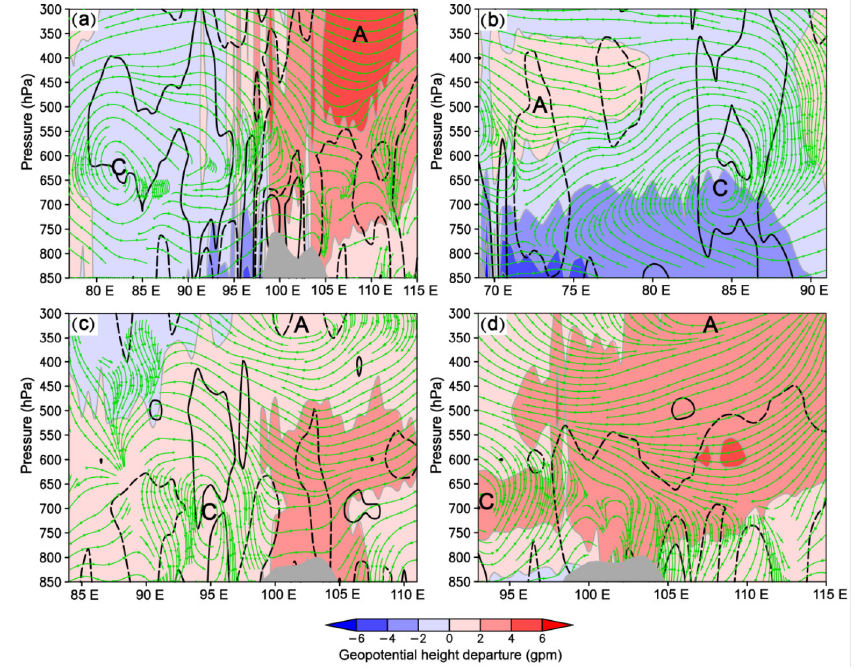
Figure 10. As in Figure 5, but for 500 hPa. The areas bounded by black lines are for the Qinghai-Tibet Plateau and the Mongolian Plateau. ( a ) March; ( b ) June; ( c ) October; ( d )